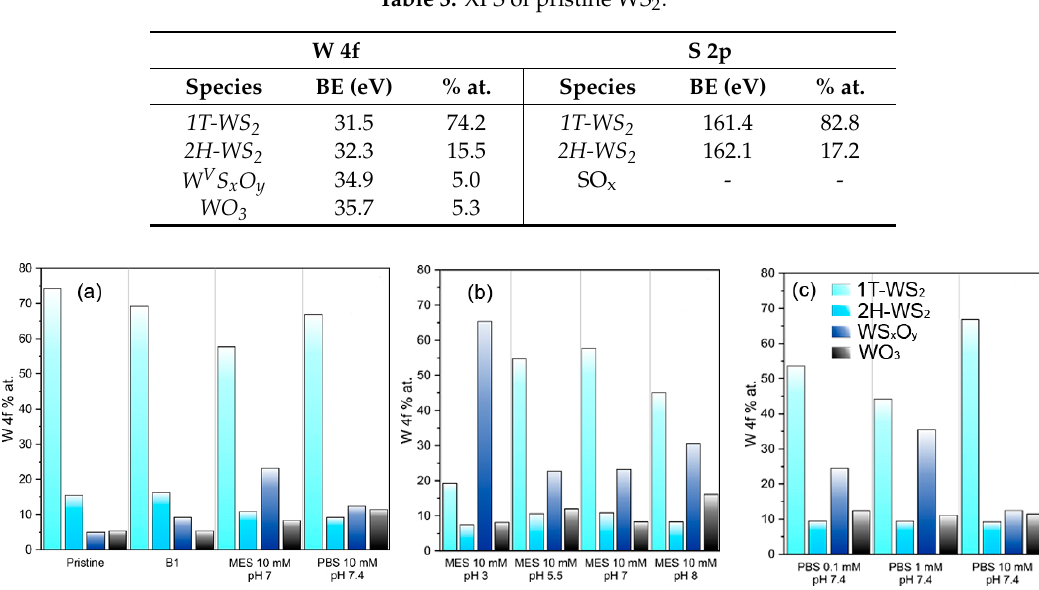
Figure 6. XPS derived composition of WS 2 in di ff erent bu ff ers (where Pristine represents DI H 2 O) ( a ), in di ff erent pH MES-based bu ff ers ( b ), and in PBS bu ff ers with increasing IS ( c